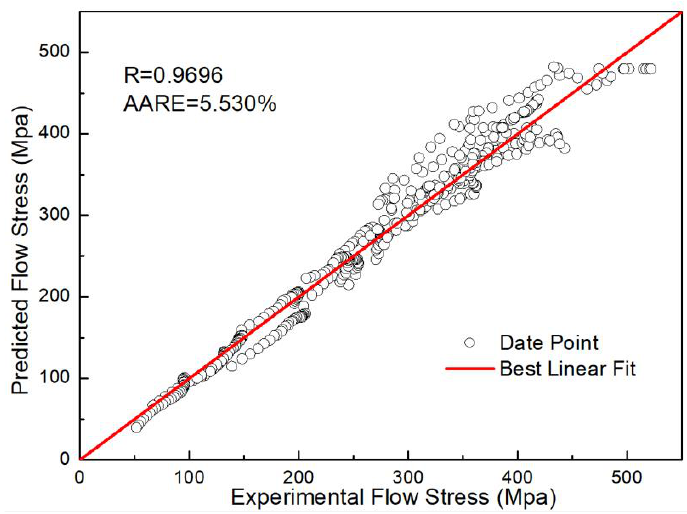
Figure 17. The comparison between predicted data and experimental data by R-MAM.